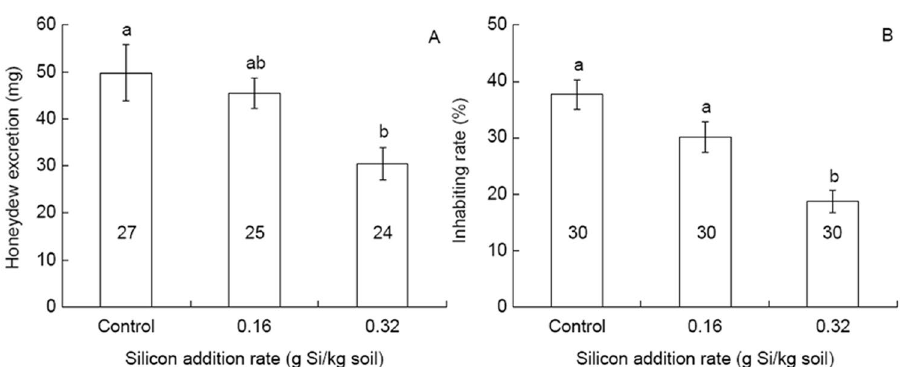
Figure 2. Effects of silicon addition to rice plants (var. TN1) on honeydew excretion ( A ) and host acceptance ( B ) in Nilaparvata lugens adults. Values are expressed as means ± SE. Bars with different letters are significantly different (Tukey’s multiple range test, P = 0.05). Figures within the bars indicate numbers of